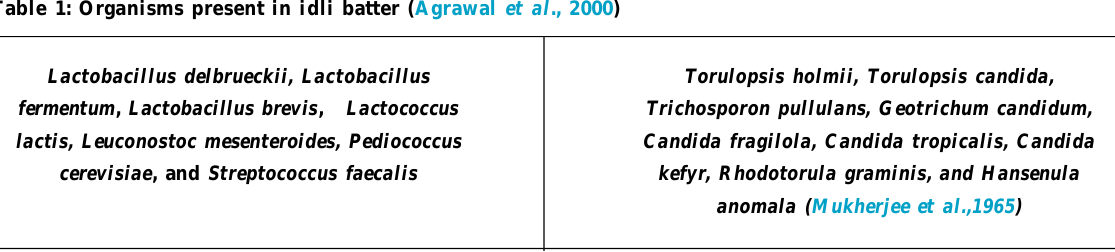
Table 1: Organisms present in idli batter (Agrawal et al ., 2000) Lactobacillus delbrueckii, Lactobacillus fermentum , Lactobacillus brevis , Lactococcus lactis, Leuconostoc mesenteroides, Pediococcus cerevisiae , and Streptococcus faecalis